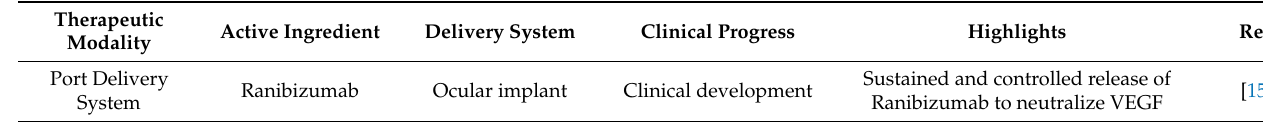
Table 4. Therapeutic and delivery strategies for